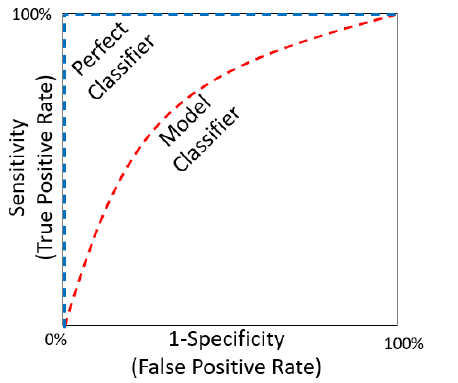
Figure 5. Receiver Operating Characteristics (ROC) diagram incorporating Sensitivity and 1-Speci- ficity.